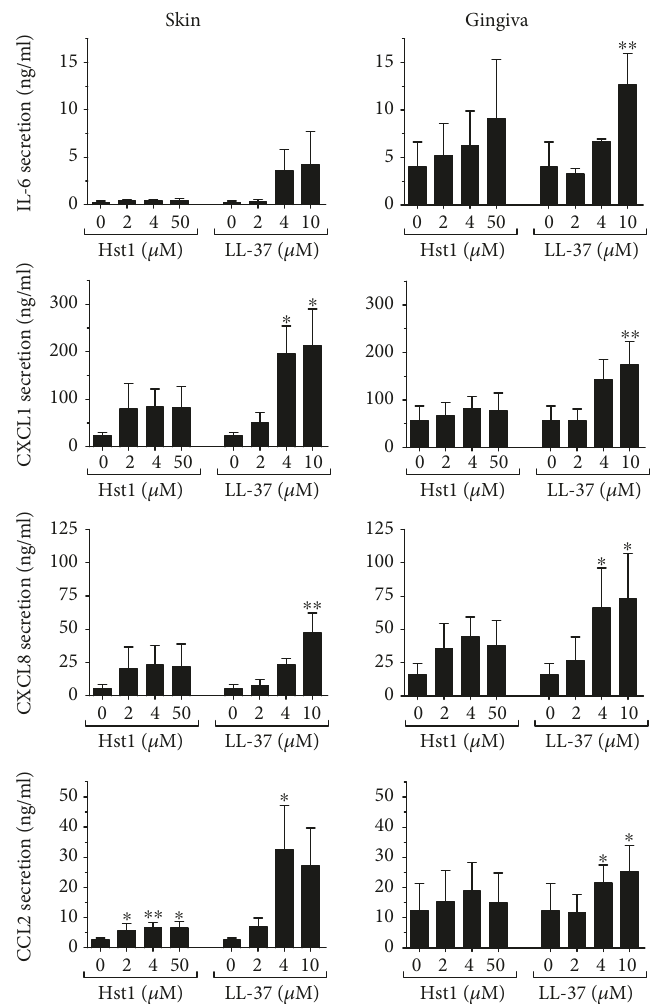
Figure 4: In fl ammatory cytokine secretion by keratinocyte- fi broblast cocultures after Hst1 and LL-37 exposure. IL-6, CCL2, CXCL1, and CXCL8 secretion after 24 hours, by skin and gingiva keratinocyte- fi broblast cocultures, is shown. Each bar represents the mean ± standard error mean of 4 independent experiments each performed in duplicate. ∗ P < 0 05 and ∗∗ P < 0 01